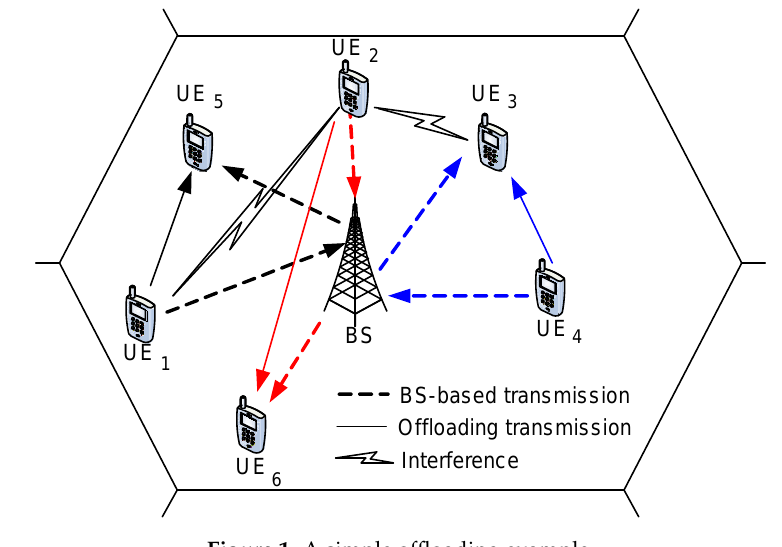
Figure 1. A simple offloading